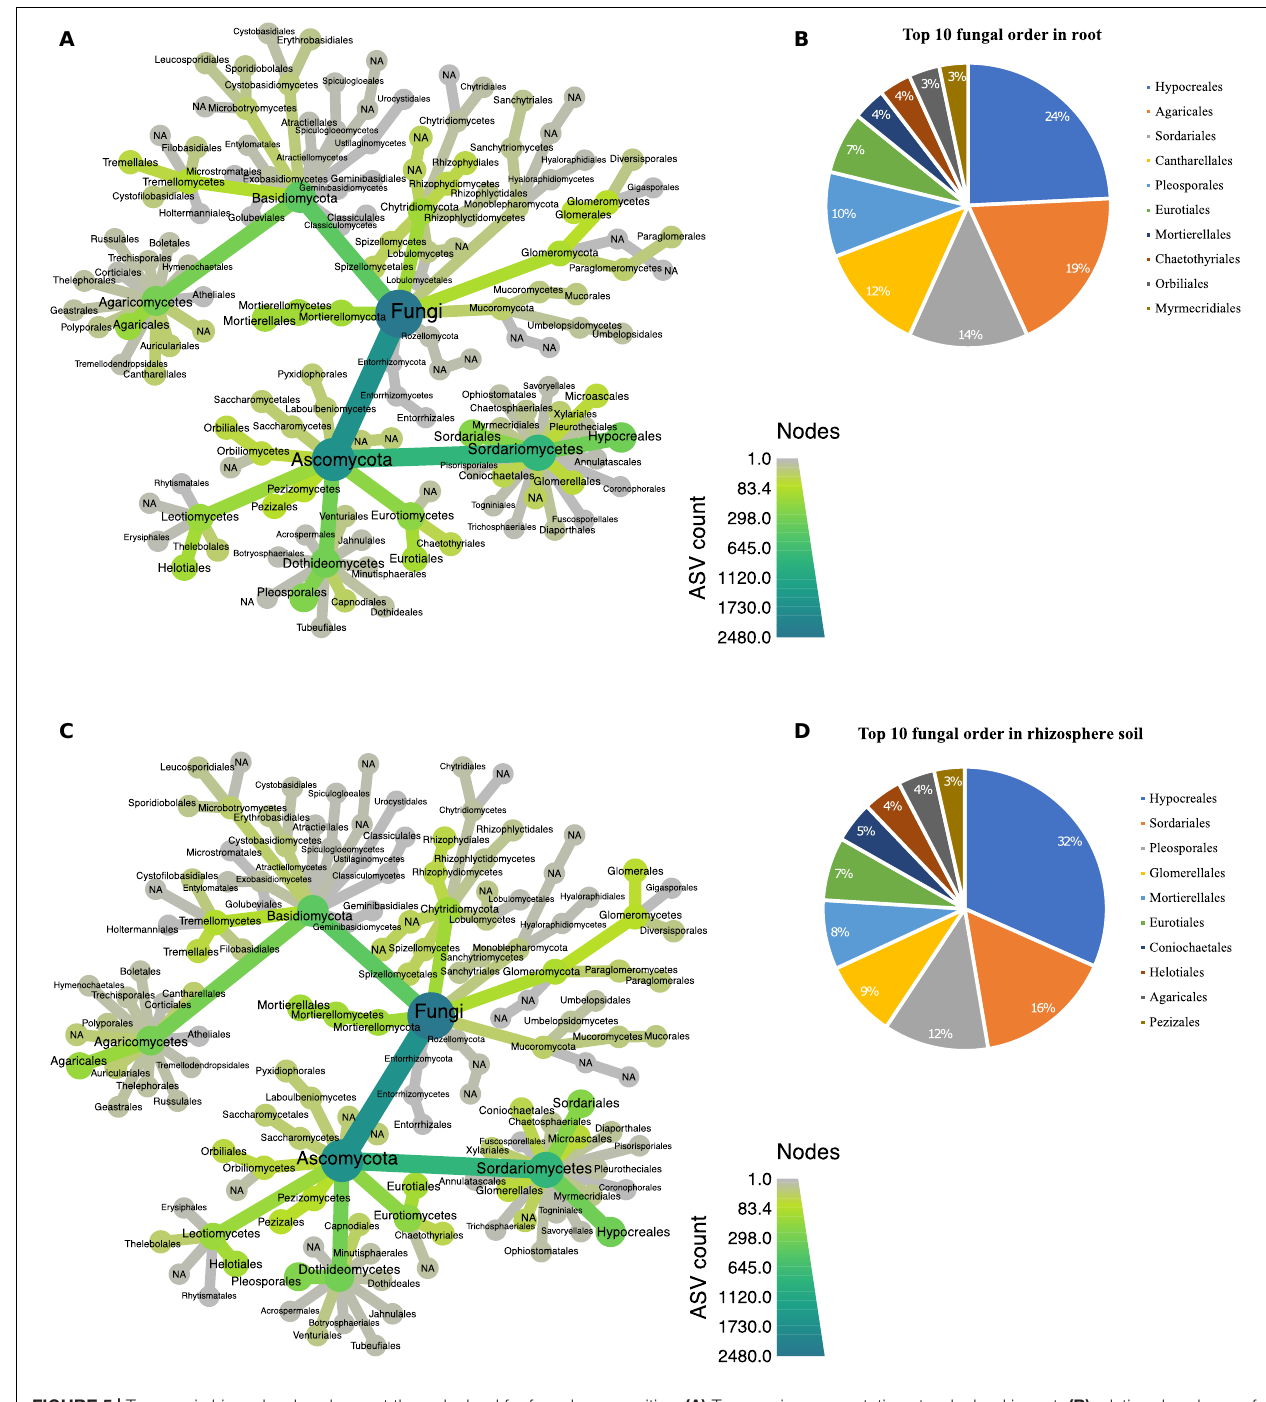
FIGURE 5 | Taxonomic hierarchy abundance at the order level for fungal communities. (A) Taxonomic representation at order level in root; (B) relative abundance of top 10 fungal orders in root. (C) Taxonomic representation at order level in rhizosphere soil (D) relative abundance of top 10 fungal orders in rhizosphere soil. Three replicates were used for this